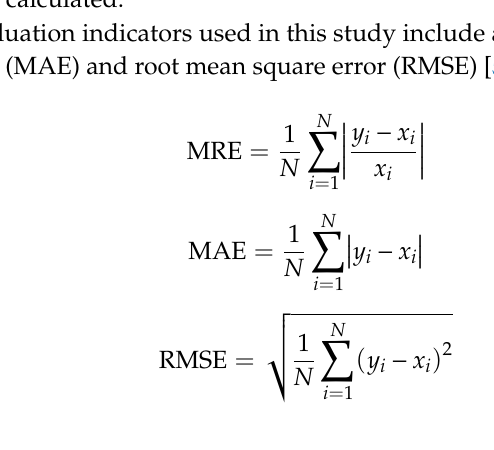
Table 4. Steps of the improved quasi-analytical algorithm (QAA).